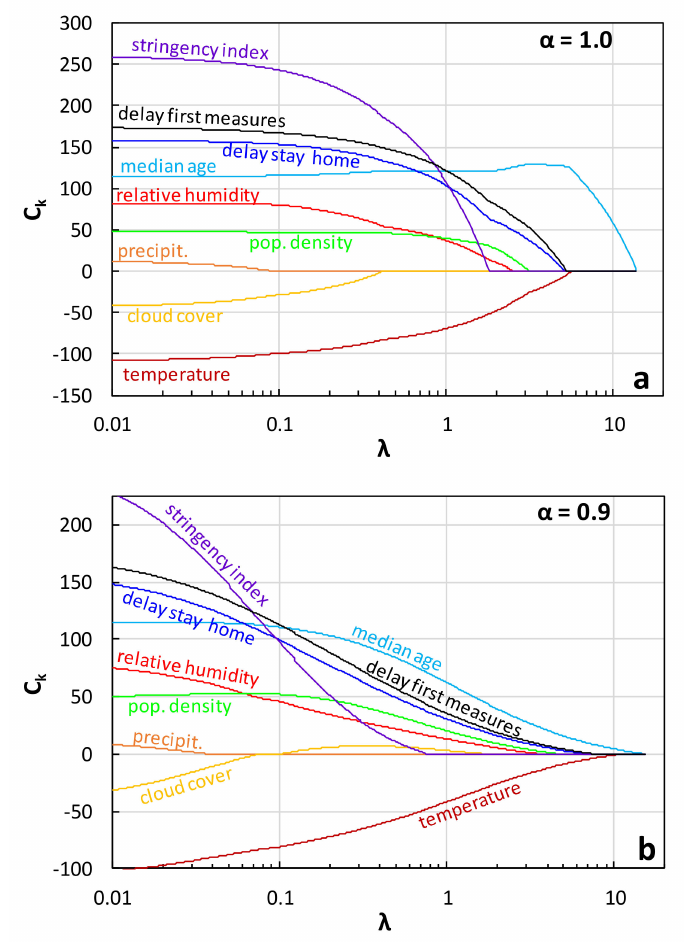
Figure 19. Trace plots of coe ffi cients from: ( a ) Lasso regression and ( b ) elastic net